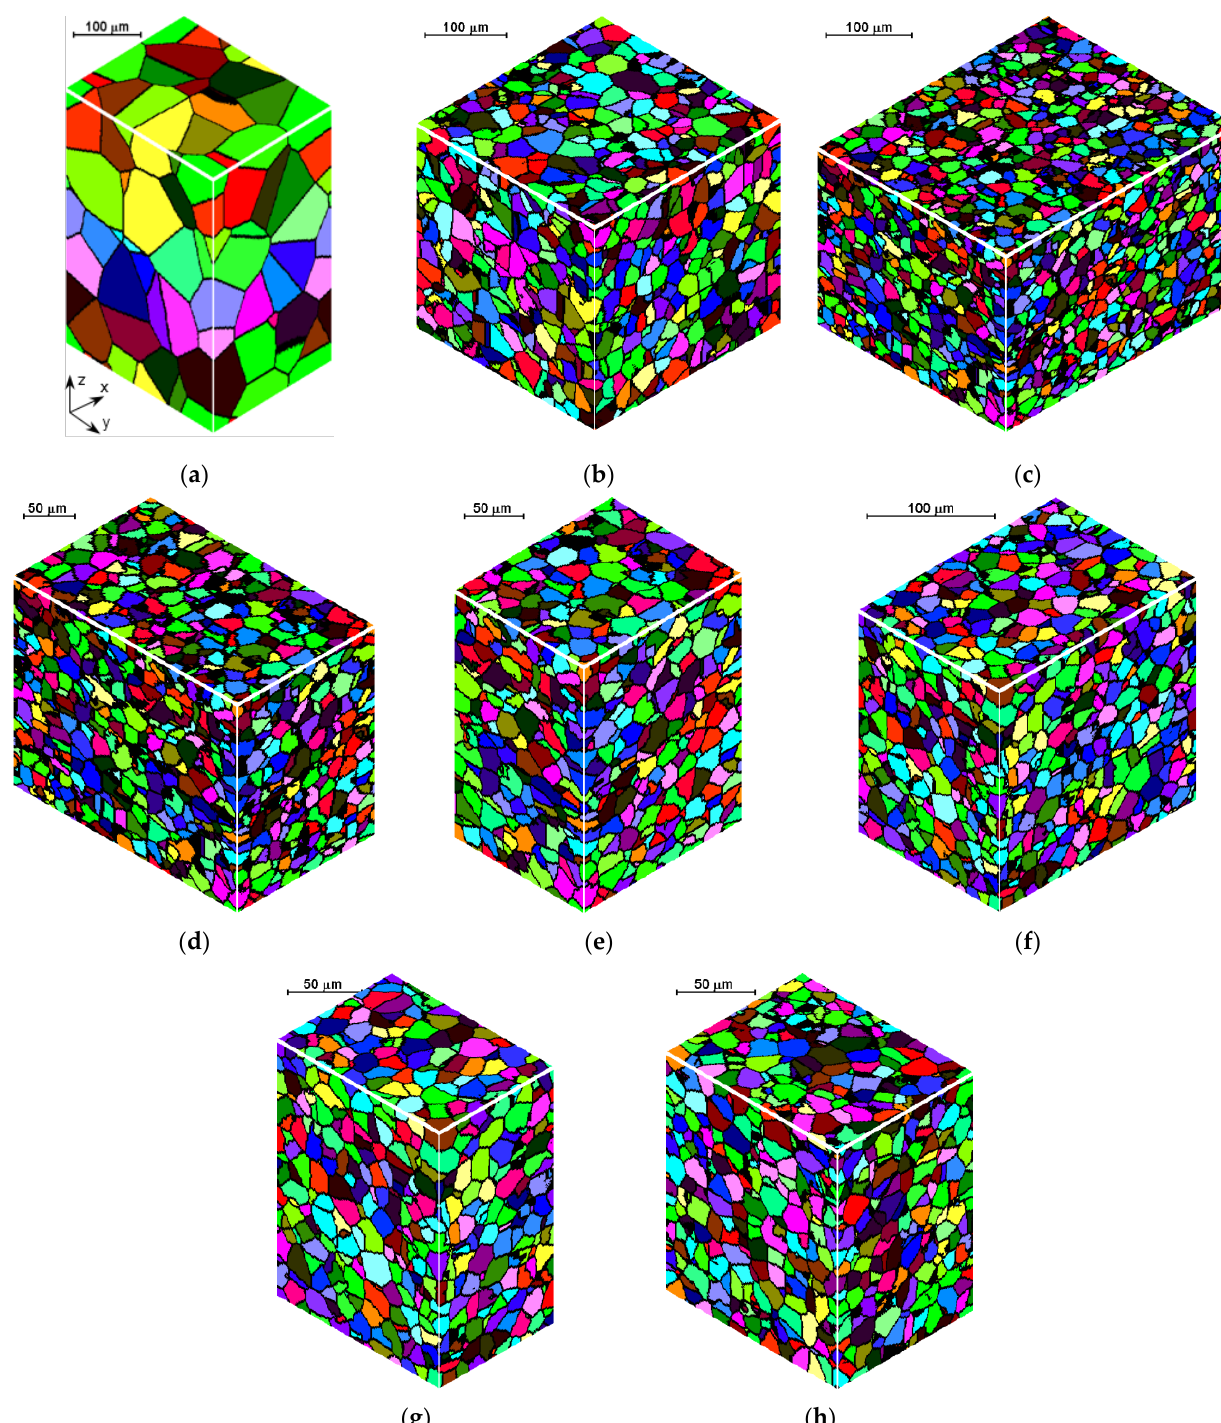
Figure 19. Microstructures: ( a ) initial, ( b ) before 2nd pass, ( c ) before 3rd pass, ( d ) before 3rd pass and after the modeled